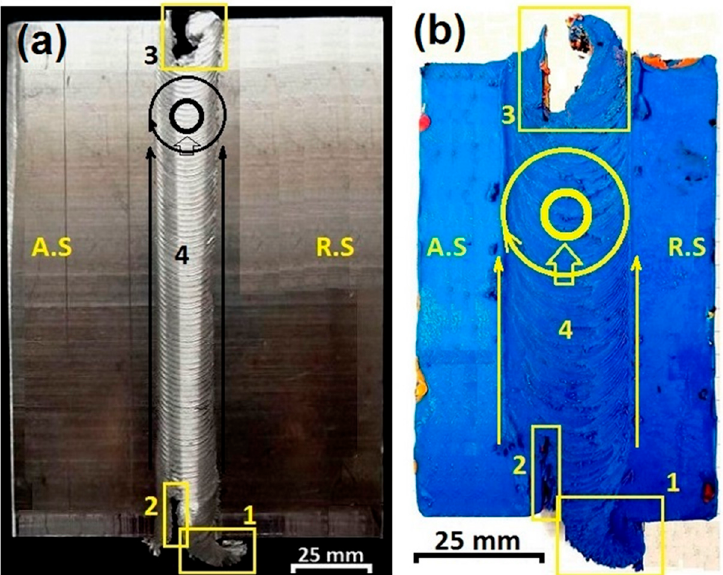
Figure 4. Top surface of the weld samples; defect features and the direction of the tool relative to the weld-line, ( a ) Aluminium plate; and ( b ) plasticine model; (1) the entry spray, (2) tunnel void discontinuity, (3) the exit zone, (4) weld-line track.